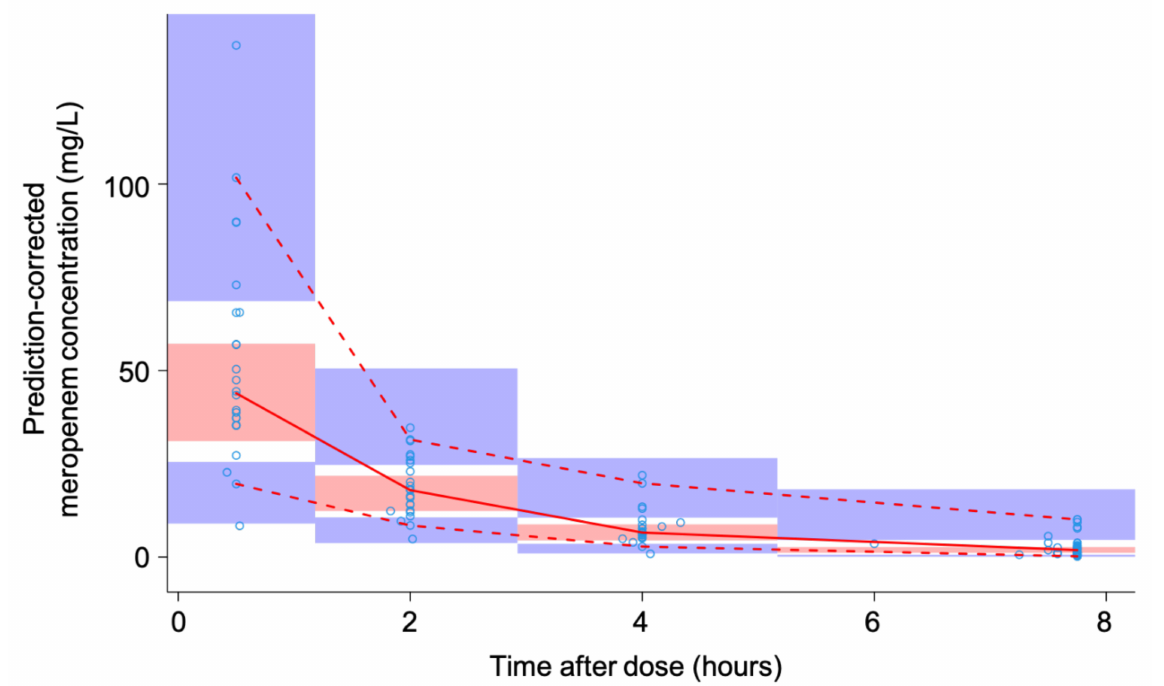
Figure 2. Prediction-corrected visual predictive check of the final population pharmacokinetic model. Blue open circles represent the observed free meropenem plasma concentrations. The solid red line is the median of the observed data. The dashed red lines are the 2.5th and 97.5th percentile of the observed data. The red and blue shaded areas indicate the 95% prediction intervals of the median and the 2.5th and 97.5th percentile, respectively, of the simulated data ( n =